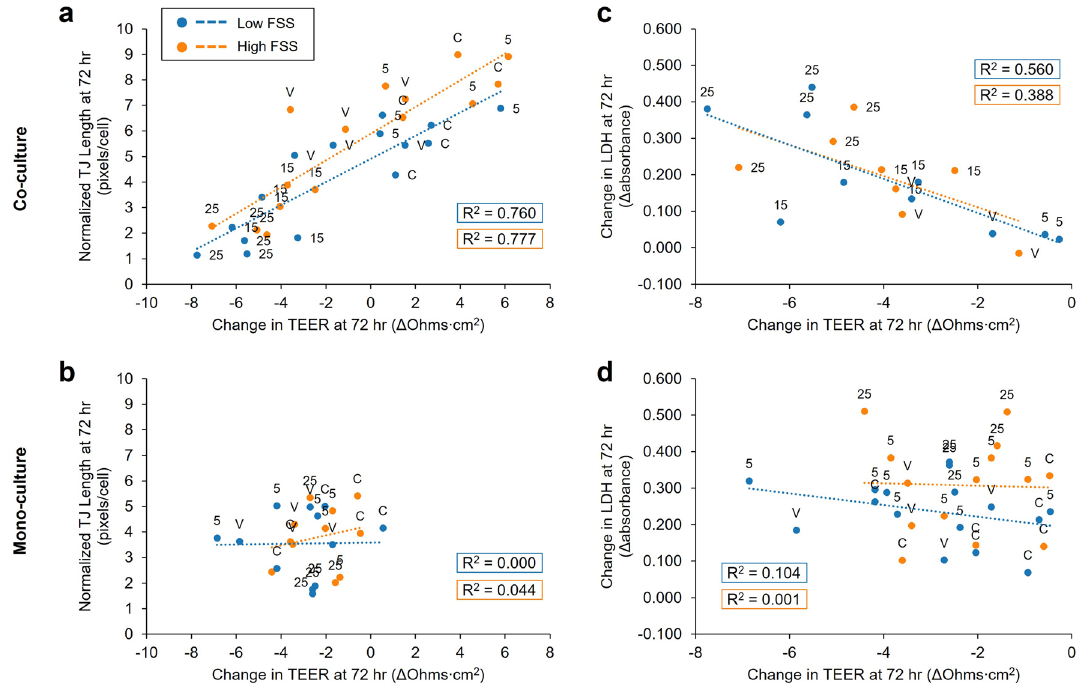
Figure 6. Change in co-culture TEER is an indicator of cisplatin-induced injury, corroborated by tight junction expression and LDH release. ( a ) Linear regression by ordinary least squares indicated a strong positive correlation between normalized tight junction (TJ) length (pixels/nuclei) and net change in TEER after 72 h for co-culture (Low FSS: R 2 = 0.732, p < 0.001, n = 15; High FSS: R 2 = 0.730, p < 0.001, n = 15). ( b ) No correlation between normalized tight junction length and TEER was evident for mono-culture (Low FSS: R 2 = 0.001, n = 12; High FSS: R 2 = 0.016, n = 11). ( c ) Linear regression also indicated a significant correlation between net change in LDH release and net change in TEER for co-culture low FSS devices that showed a decrease in barrier function (ΔTEER < 0) after 72 h (R 2 = 0.511, p = 0.020, n = 10). Fewer co-culture high FSS devices showed a decrease in barrier function after 72 h, and a linear model between net changes in LDH and TEER for these devices did not reach statistical significance (R 2 = 0.326, p = 0.139, n = 8). All data points represent biological replicates from N = 1 experimental replicate. ( d ) Changes in LDH and TEER were not correlated for mono-cultures under either low or high FSS (Low FSS: R 2 = 0.169, p = 0.102, n = 17; High FSS: R 2 ~ 0, n = 14). Data labels ( a - d ): (5,15,25) cisplatin concentration in μM, (C) untreated control, and (V) vehicle